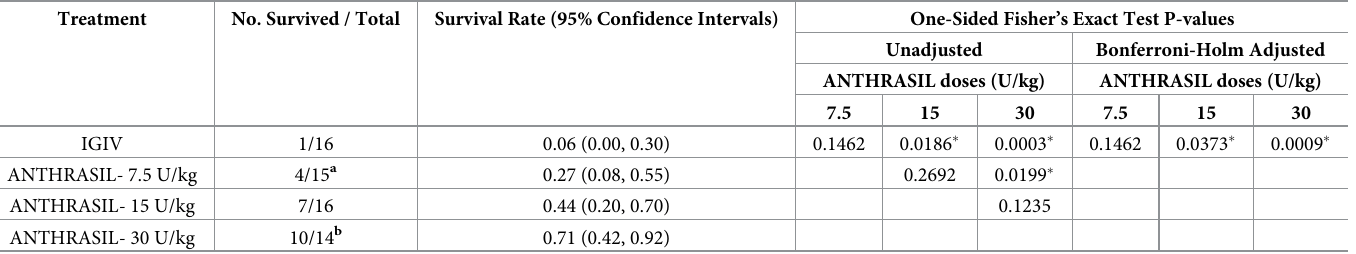
Table 6. Survival rates of B . anthracis -infected nonhuman primates treated with IGIV and ANTHRASIL (Intent-to-treat group).